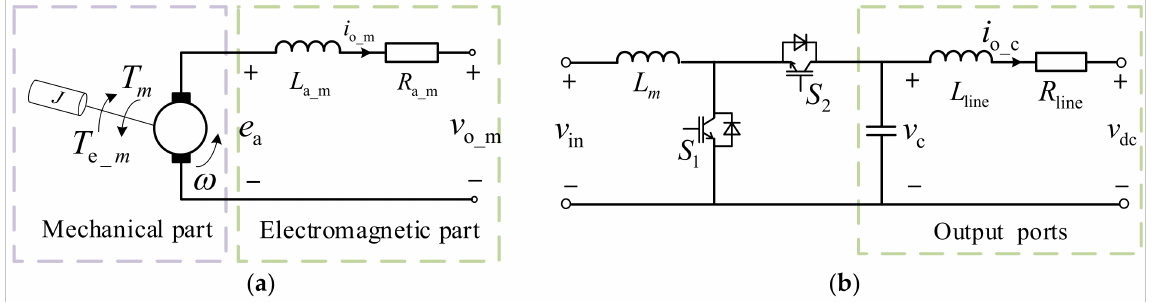
Figure 14. Analogy between dc machine and dc/dc converter: ( a ) The dc machine equivalent circuit; ( b ) The non-isolated bi-directional dc/dc converter